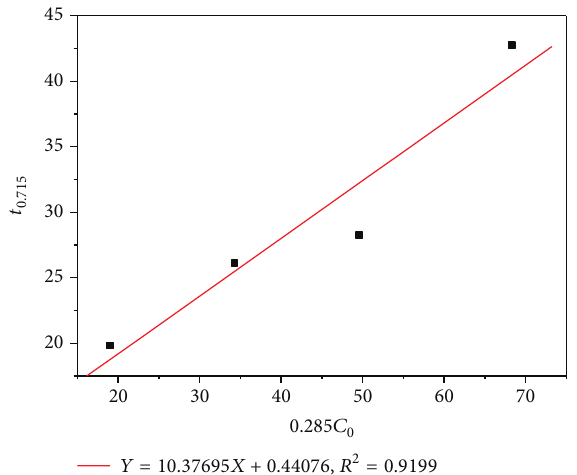
Figure 9: L-H kinetic model of magnetic photocatalysts of Ni-Zn ferrite/TiO 2